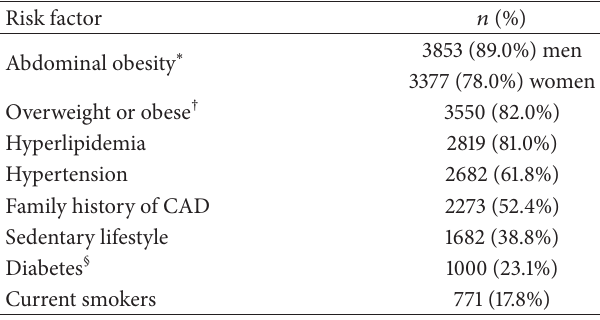
Table 2: Patient risk factor status at program